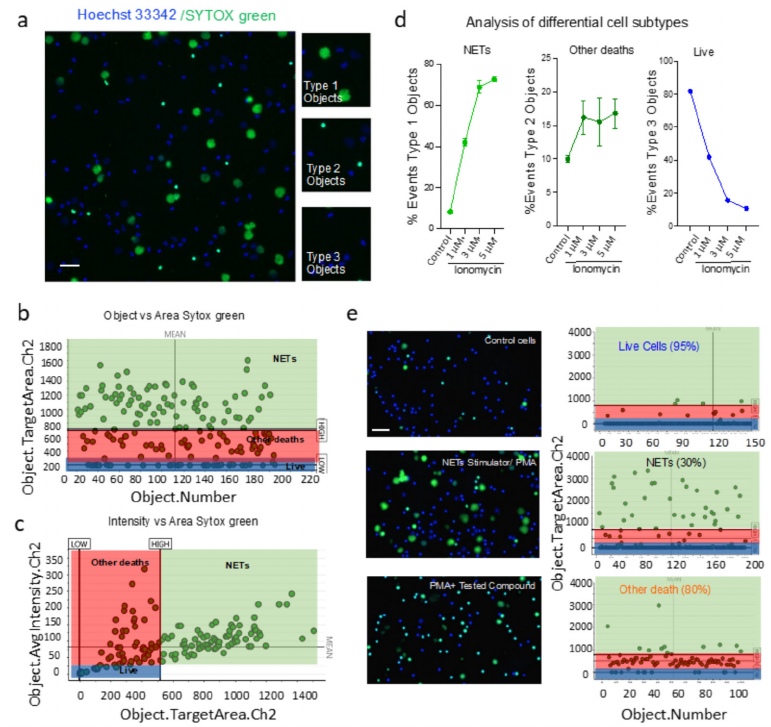
Figure 4. HCS-Cellomics analyses discriminate NETs from other death pathways. ( a ) Representative image and Ch2 target area analysis of neutrophils treated with 1.5 µ M Ionomycin. Inserts define distinct cell types observed. Type 1 events, i.e., NET forming cells were positive for green and big decondensed nucleus, Type 2 events, i.e., green and small cells that were undergoing death through pathways other than NETs. Type 3 objects as live cells. Scale bar; 50 µ m. ( b , c ) Target area channel 2 analysis and its comparison to target mean intensity channel 2 provides discrimination between live, dead, and NET forming cells. ( d ) Quantification of cells exhibiting NET formation, cell undergoing distinct death or live cells. ( e ) Images of neutrophils undergoing NETs and other death forms in response to 10 µ M of tested compound, Dot plot analysis of Target area channel 2-differentiated NET forming cells and other death